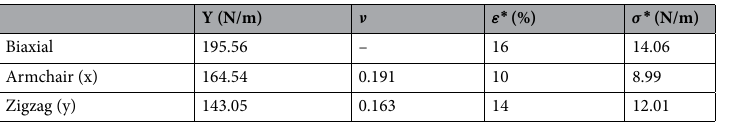
Table 2. Mechanical parameters of the α ′ -4H borophene: Young’s modulus (Y), Poisson’s ratio ( ν ), critical strain ( ε ∗ ), and ideal strength ( σ ∗